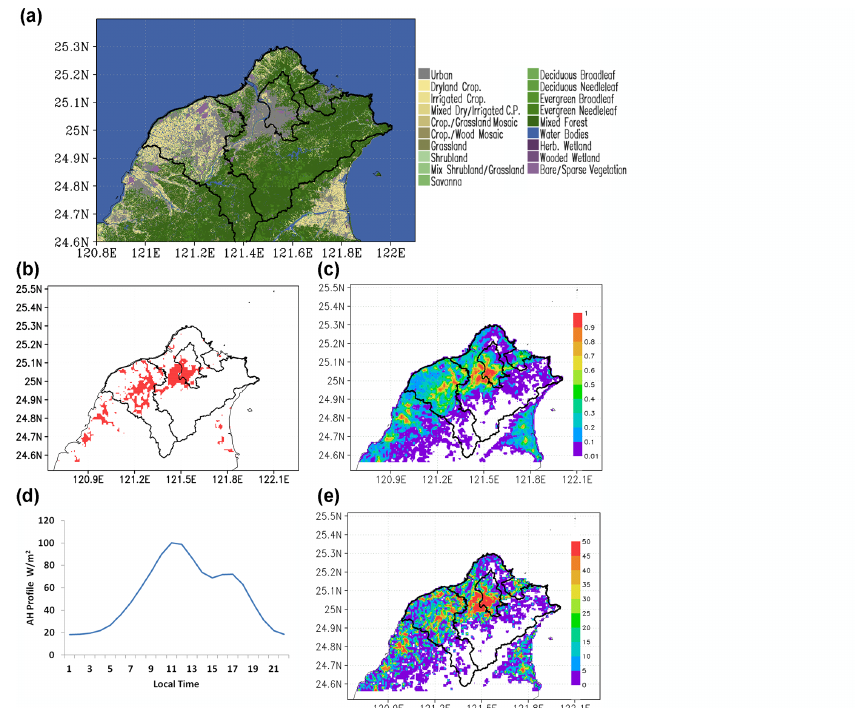
Figure 2. Panel (a) : land use data at 100m resolution obtained from the National Land Surveying and Mapping Center, Taiwan, for 2006. Spatial distribution of urban areas simulated at 1km resolution (b) by WRF–UCM with an urban fraction fixed at 0.7 and (c) by WRF– UCM2D with an urban fractions ranging from 0.01 to 1.0. Panel (d) : diurnal variation of AH used in model simulation. Panel (e) : spatial distribution of AH ranging from 0 to 50Wm − 2 simulated by WRF–UCM2D at 1km resolution. The following abbreviations are used in the legend: Crop. – cropland; C. P. – cropland and pasture; Herb. –